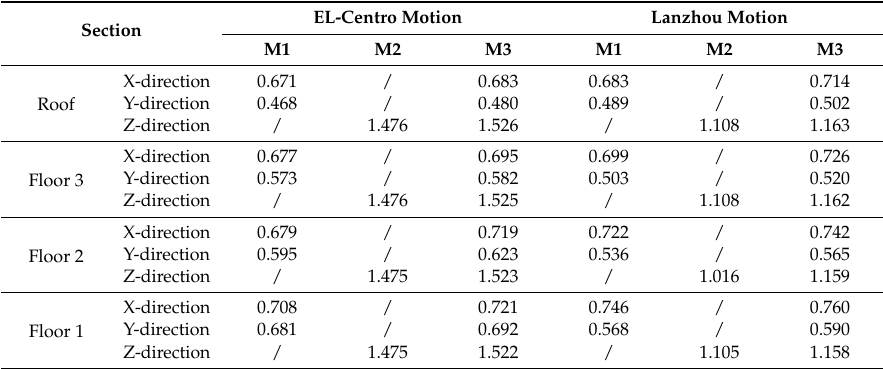
Table 3. Acceleration amplification factors under 0.20